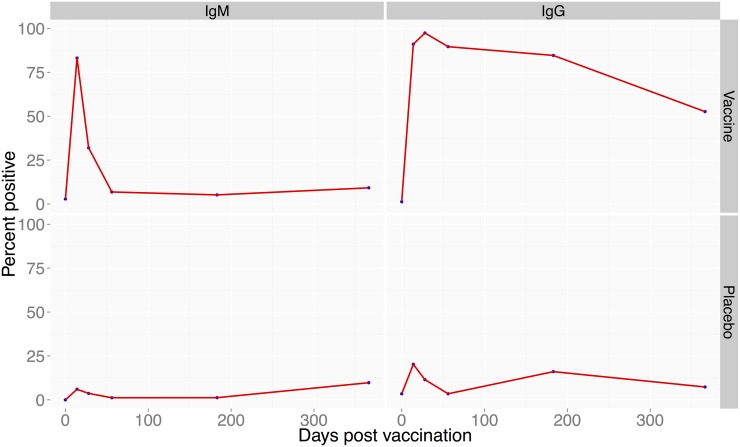
Proportion of sheep positive for anti-RVF antibodies following vaccination with RVF Clone 13 vaccine.Left panel (bottom) shows proportion of sheep showing IgG antibodies following vaccination within 14 to 366 days post-vaccination. The right panel (bottom) shows proportion of sheep that produced anti-RVF IgM antibodies. The top panel on the left and right are the placebo-treated animals.